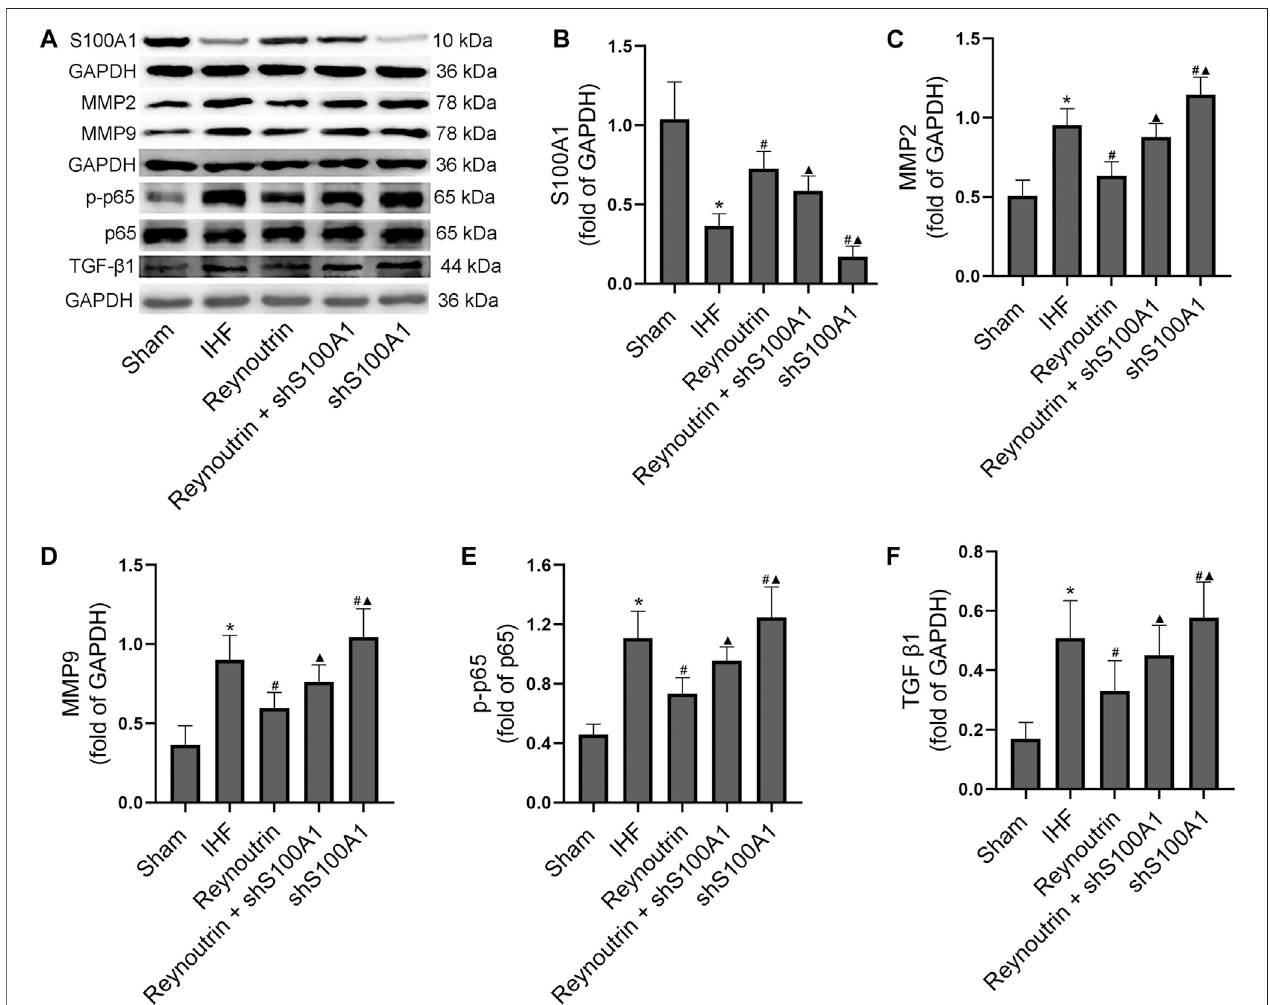
FIGURE 7| Effects of reynoutrin and S100A1 knock-down on protein expressions in myocardial tissue ofrats. The dose of reynoutrin here was50 mg/kg. (A) The representative blots of S100A1, MMP2, MMP9, p-p65, p65, TGF- β 1 and GAPDH in each group. (B) Semi quantitative analysis of S100A1 in each group. (C) Semi quantitative analysis of MMP2 in each group. (D) Semi quantitative analysis of MMP9 in each group. (E) Semi quantitative analysis of p-p65 in each group. (F) Semi quantitative analysis of TGF- β 1 in each group. The values presented as the means ± standard error in each experiment group ( n (cid:1) 10). * p < 0.05 vs. Sham group; # p < 0.05 vs. IHF group; ▲ p < 0.05 vs. Reynoutrin